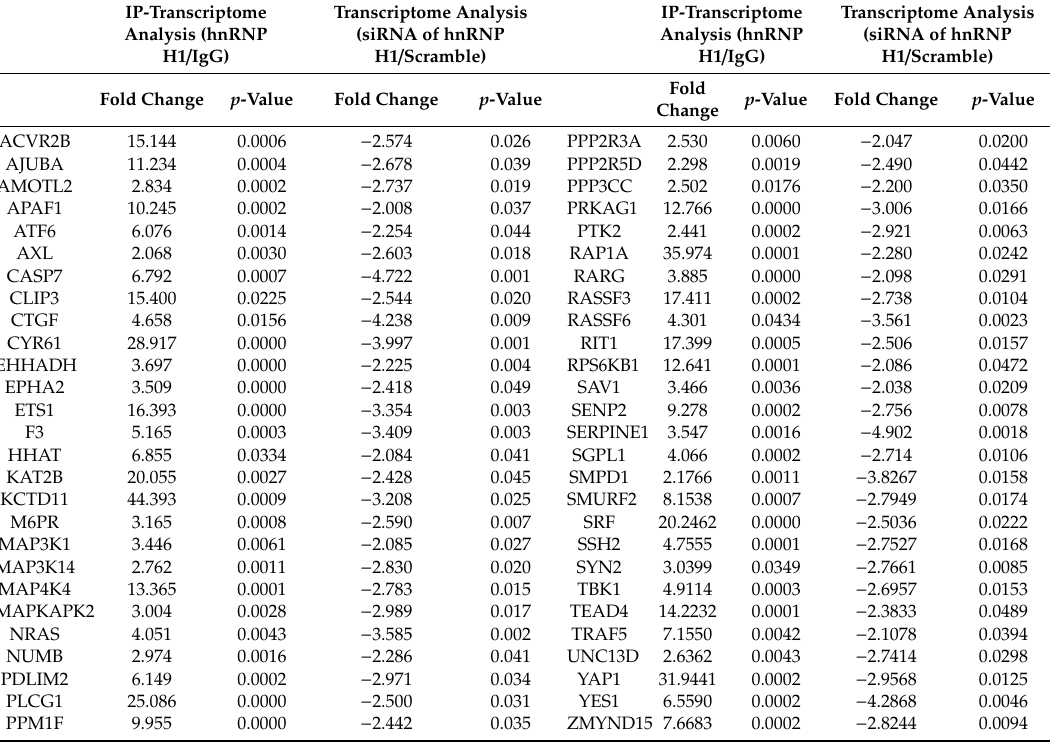
Table 1. List of apoptosis-related mRNAs regulated by hnRNP